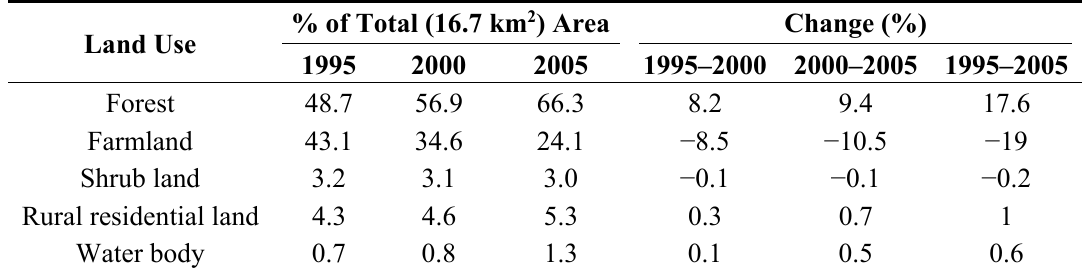
Table 1. Changes in different land use categories as a percentage of the total watershed